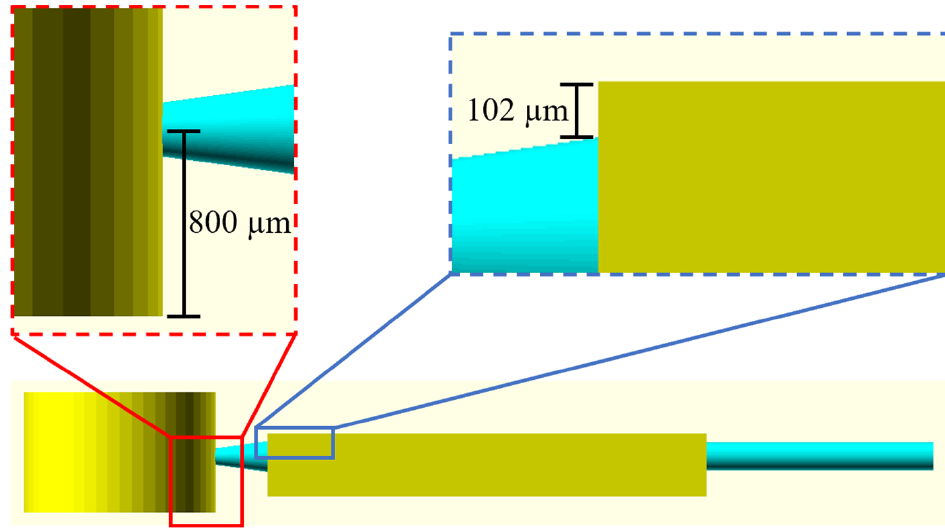
Figure 4. CAD design of Device 15 with the connecting channel between the inlet reservoir and the sedimentation trench placed 800 µ m above the bottom layer of the reservoir (red), and a hydrophobic air barrier of 102 µ m placed at the top of the sedimentation trench (blue) to enhance separation of plasma from whole blood.